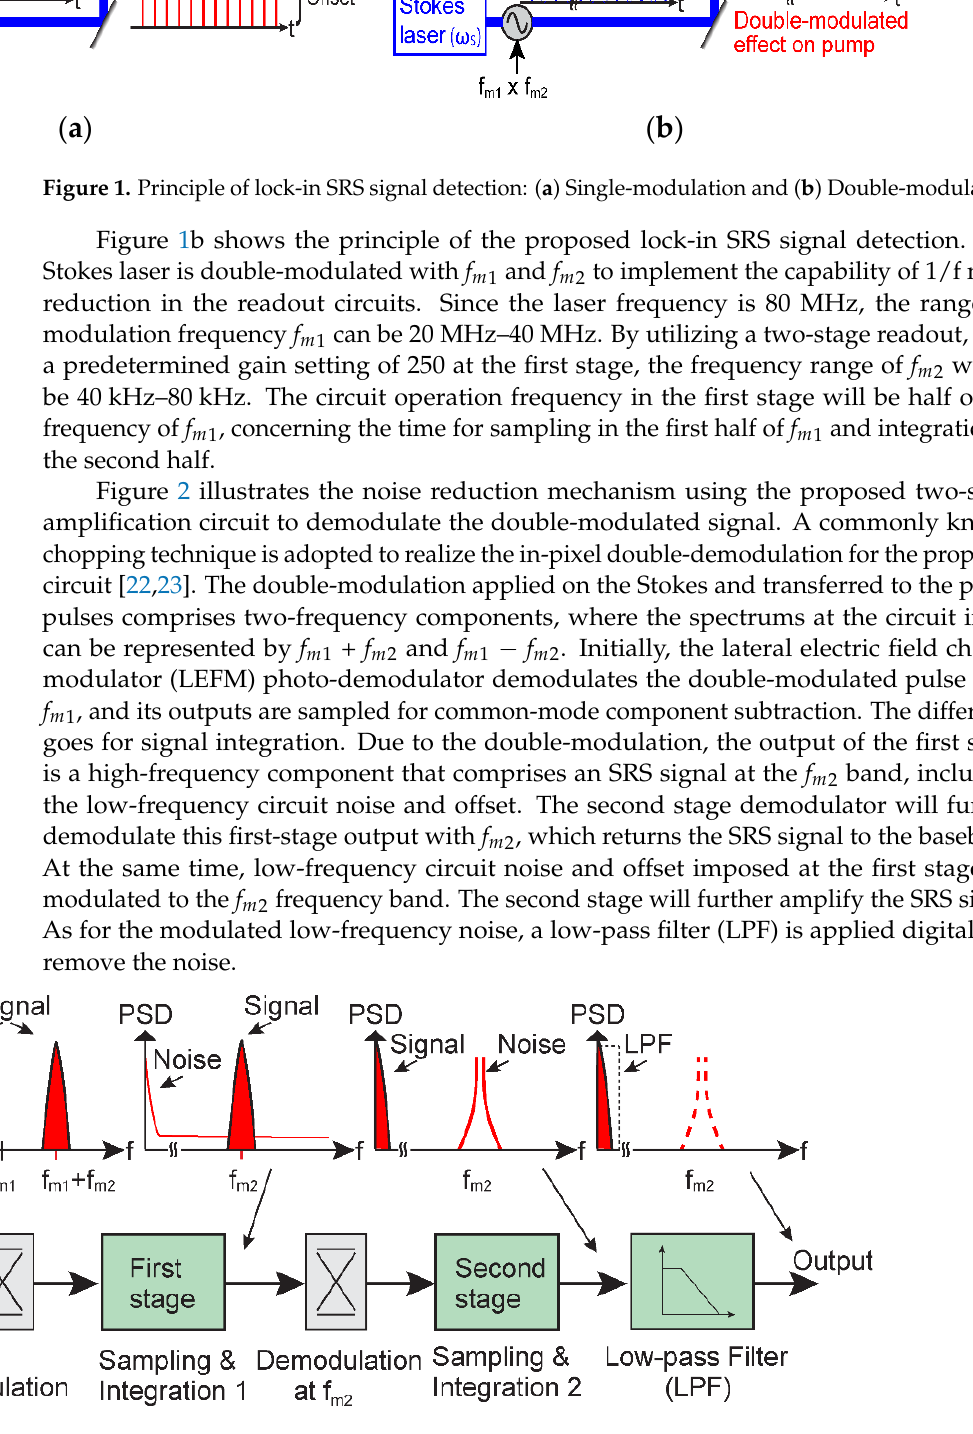
Figure 1. Principle of lock ‐ in SRS signal detection: ( a ) Single ‐ modulation and ( b ) Double ‐ modula ‐ tion.